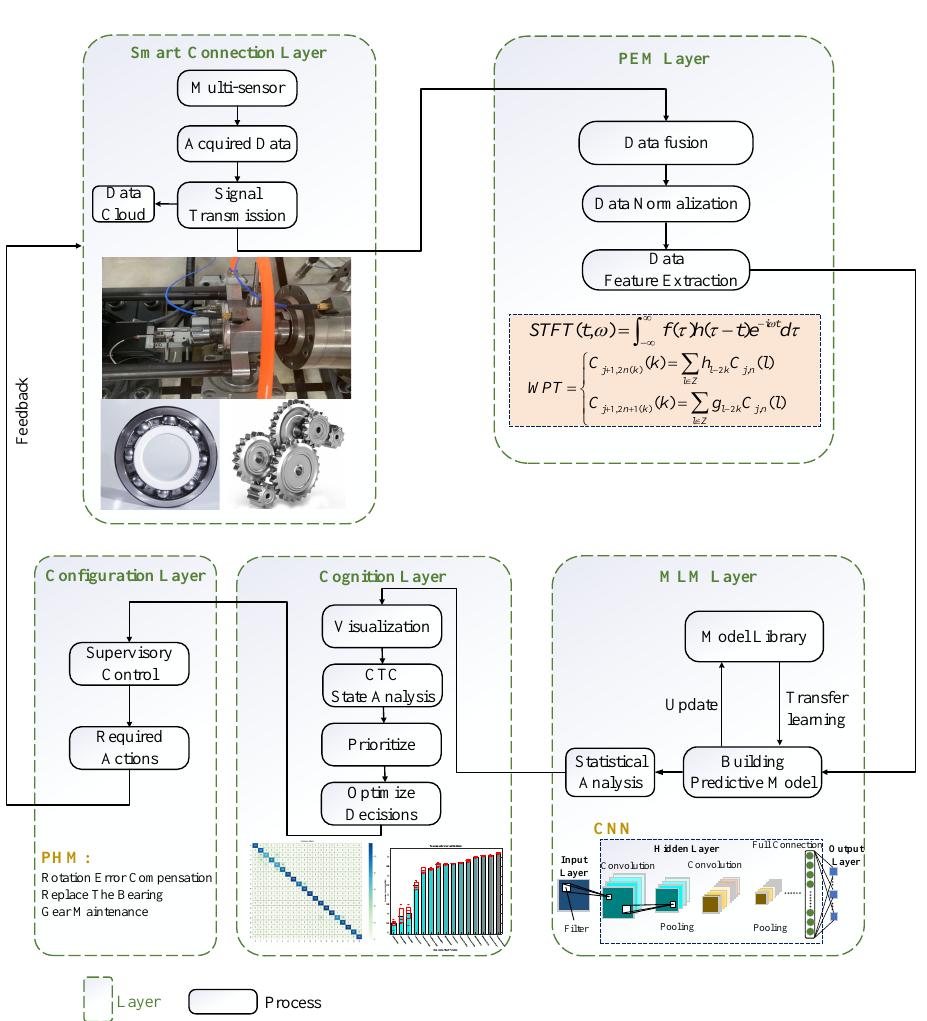
Figure 1. CPS framework for CTC condition monitoring and reliability